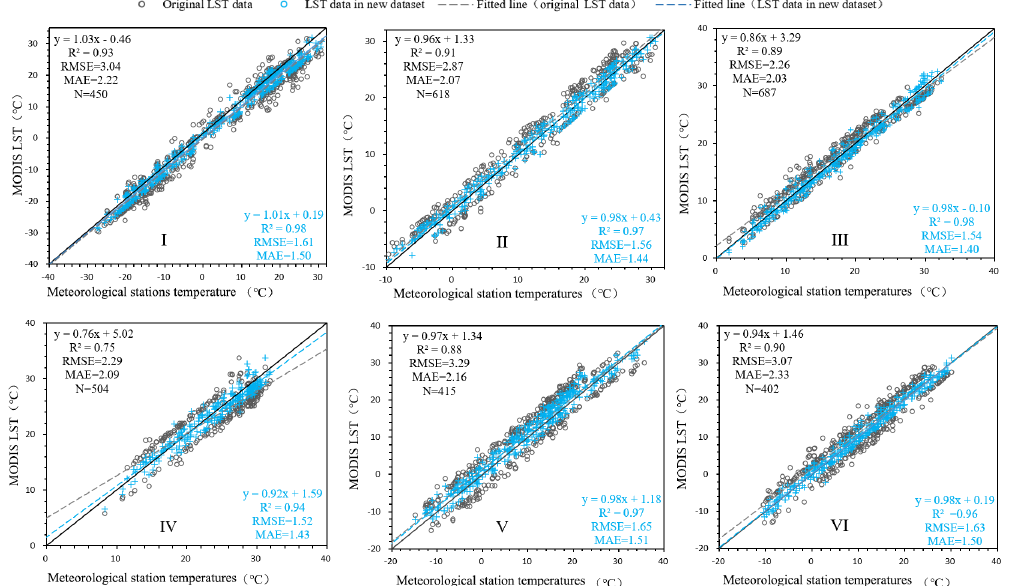
Figure 6. The scatter diagrams of the low-quality MODIS LST data and reconstructed results versus their corresponding ground station data in six natural subregions (I, II, III, IV, V and VI). The gray points indicate low-quality LST pixel values in the original MODIS LST data. The blue points represent the values in the new LST dataset, and the statistical accuracy measures ( R 2 , RMSE and MAE) are also